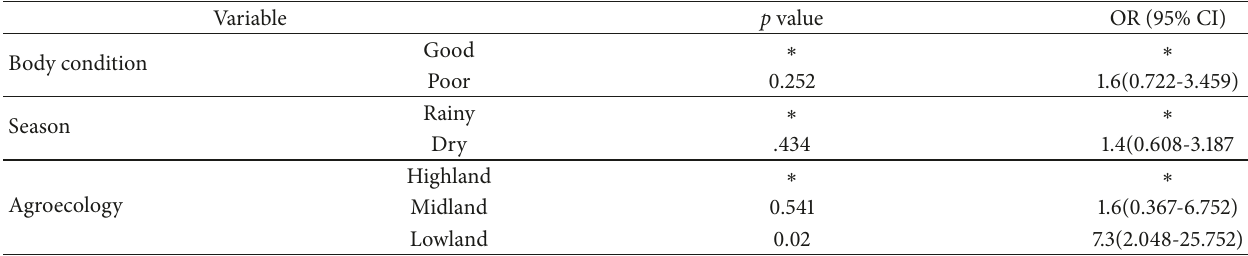
Table 4: Multivariable logistic regression analysis of risk factors for seroprevalence of CBPP.